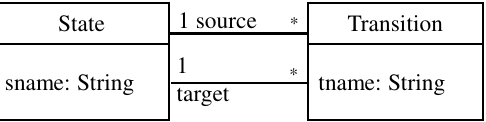
Figure 8. An attributed type graph (ATG). The star (*) indicates that zero or more instances of the class “Transition” are associated with one instance of the class “State”.